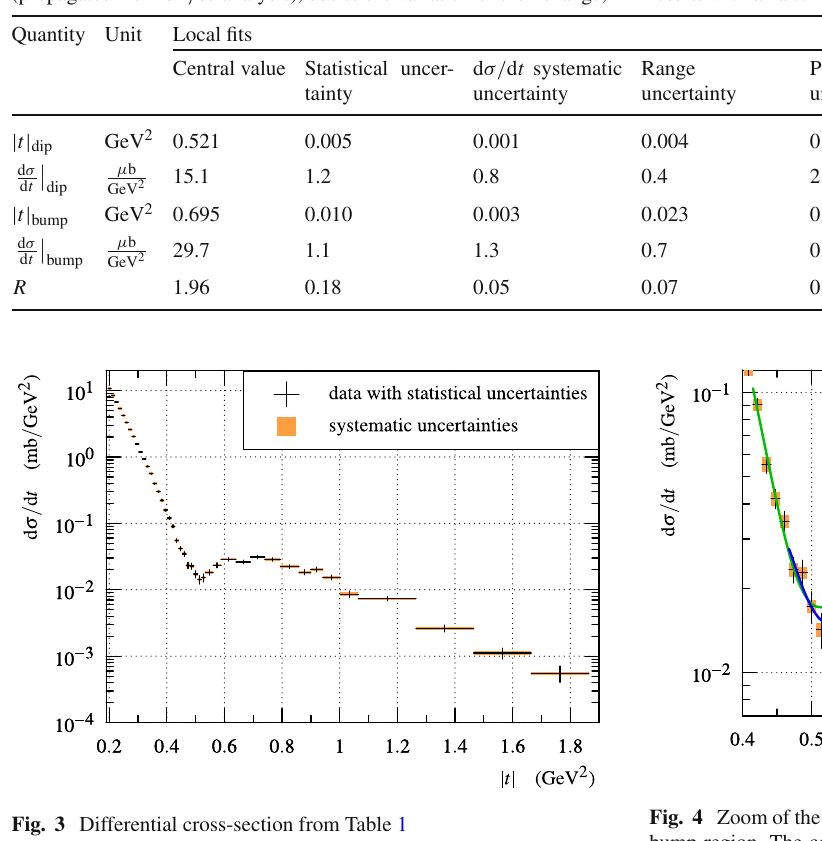
bump region. The coloured curves correspond to the fits discussed in the